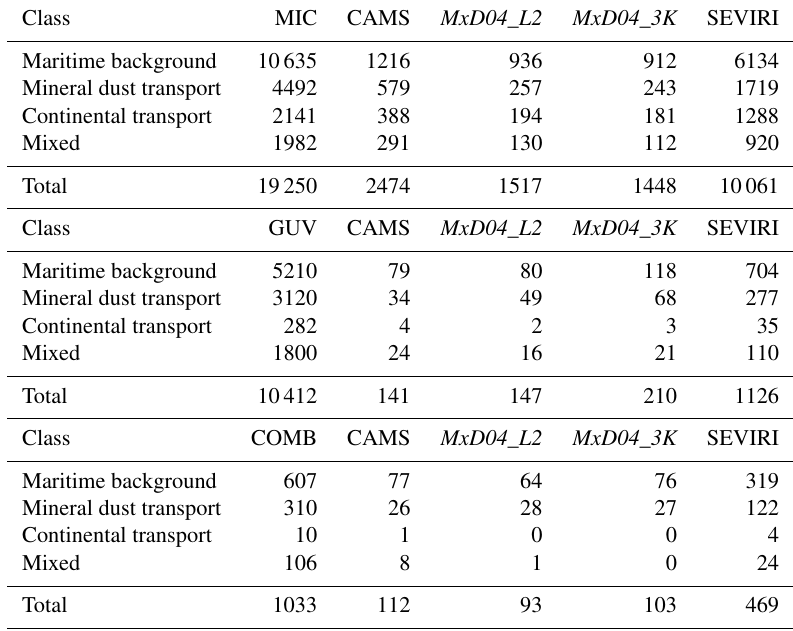
Table 2. Number of available data points in the Microtops (MIC), GUV, and COMB datasets, given as total number and separated by aerosol type. The type classification follows the scheme of Toledano et al. (2007). Collocated data points for the comparison with satellite and model datasets (see text for collocation criteria) are also